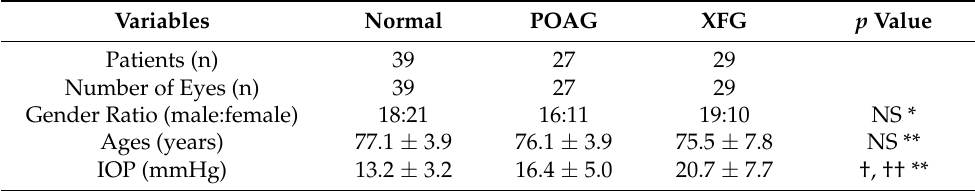
Table 1. Demographic characteristics of the study